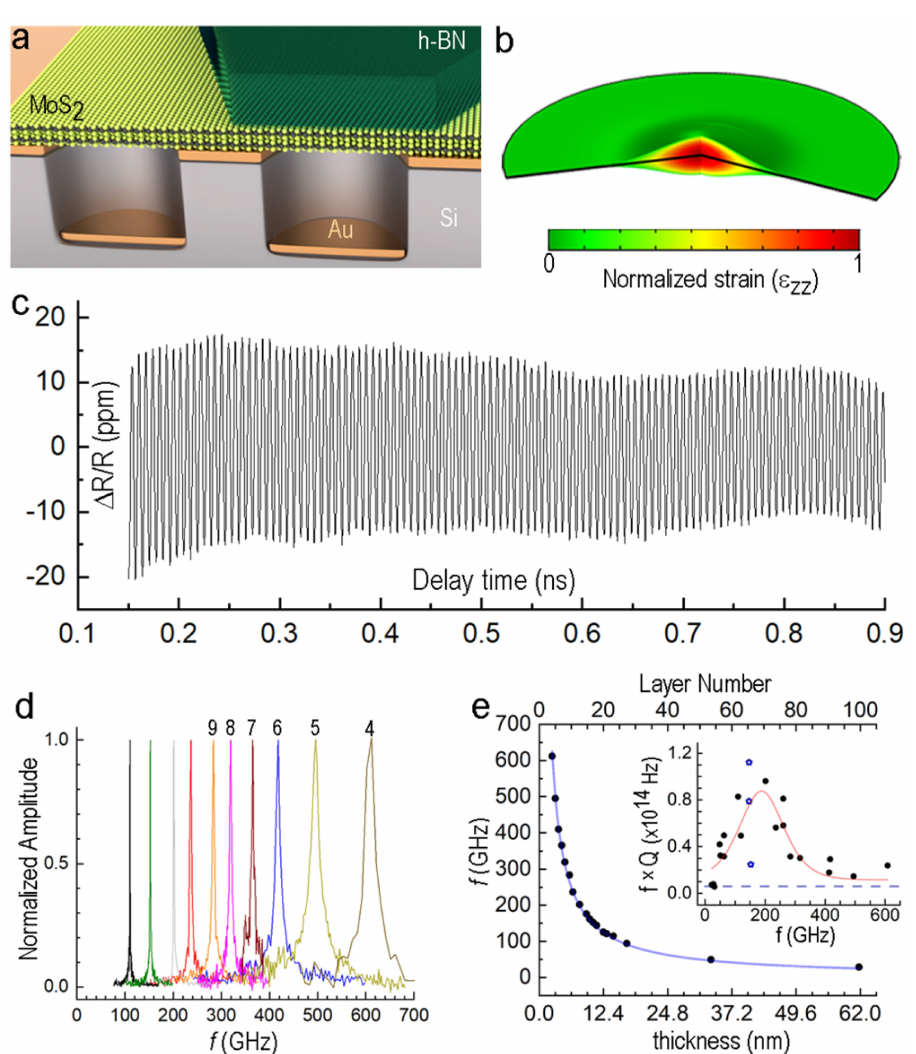
Figure 13. 2D heterostructure-based acoustic cavities: ( a ) Illustration of MoS 2 / h -BN heterostructure- based acoustic cavities. ( b ) Finite-element modeling simulation of the normalized mechanical strain of suspended MoS 2 . ( c ) Time-varying reflectance of suspended MoS 2 . ( d ) Time-dependent reflectivity spectra from various MoS 2 cavities calculated via FFT. ( e ) The quantity of MoS 2 determines the frequency of various MoS 2 acoustic cavities. Adapted with permission from Ref. [172]. Copyright 2021, Nature Publishing